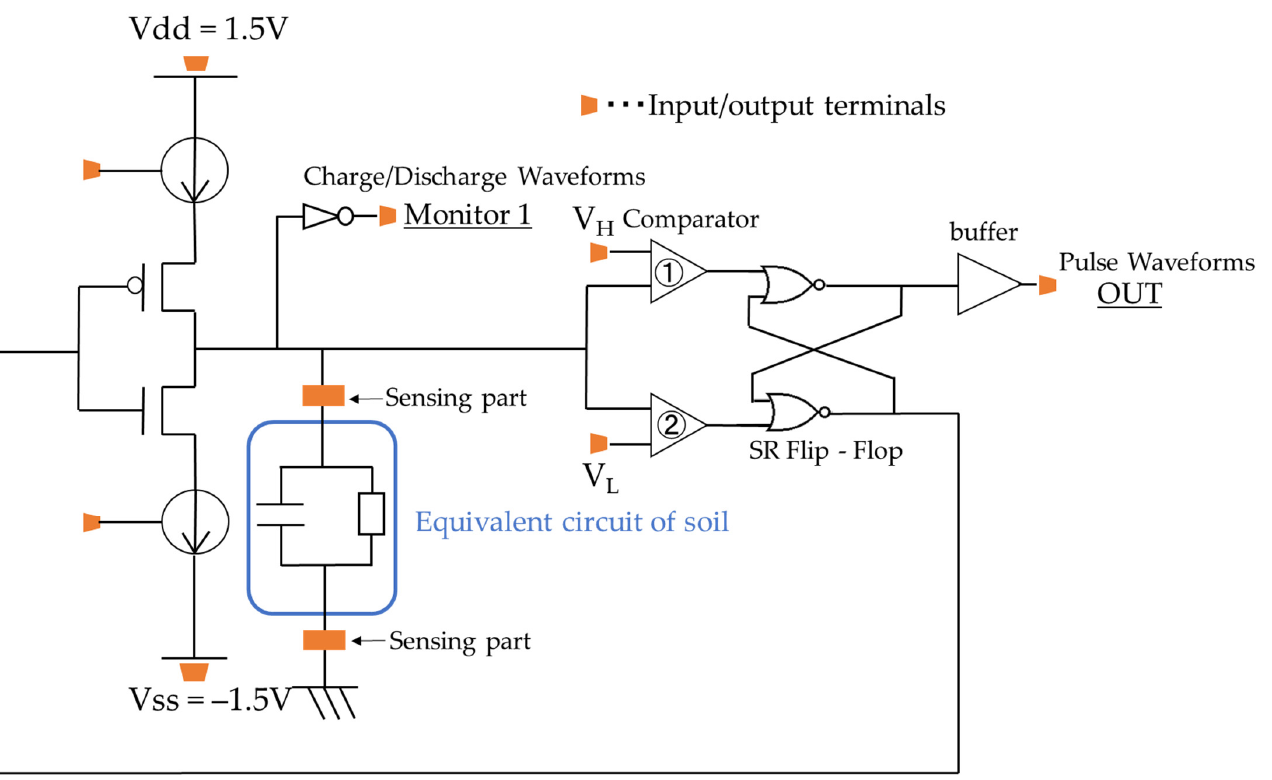
Figure 5. Measurement circuit.